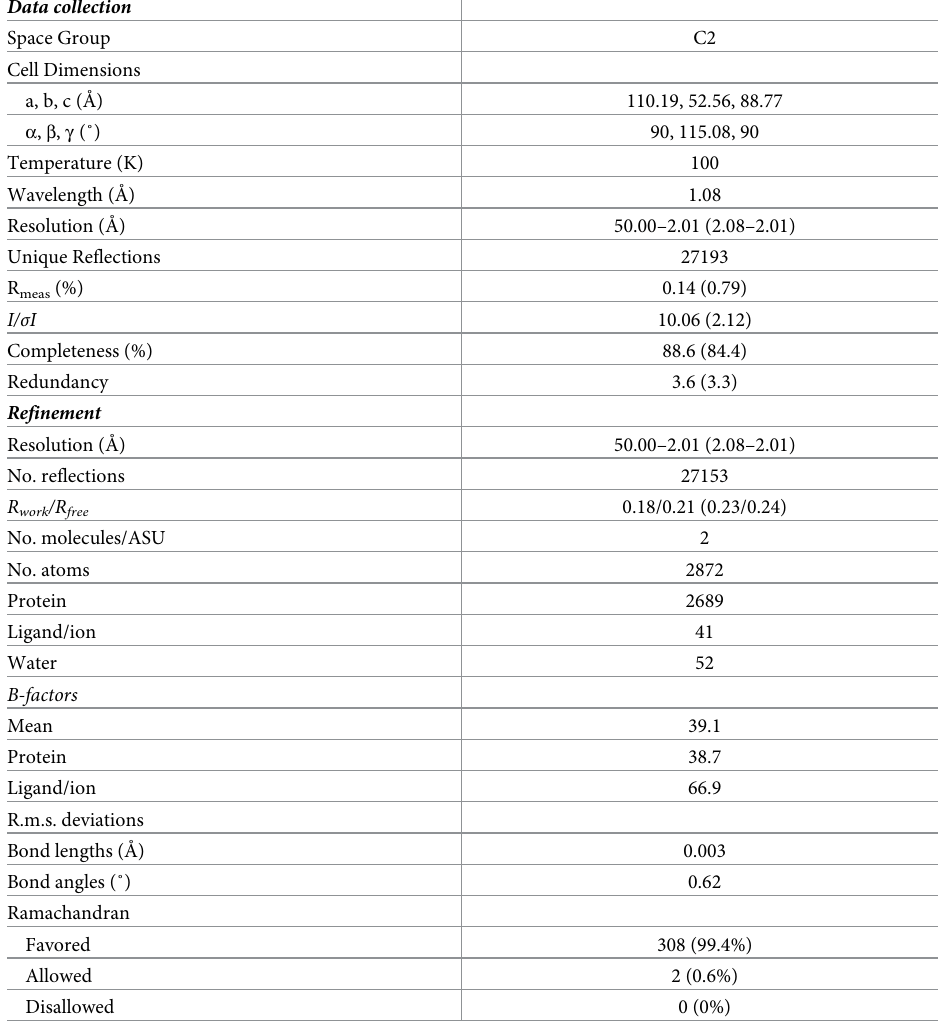
Table 1. Crystallographic data collection and refinement